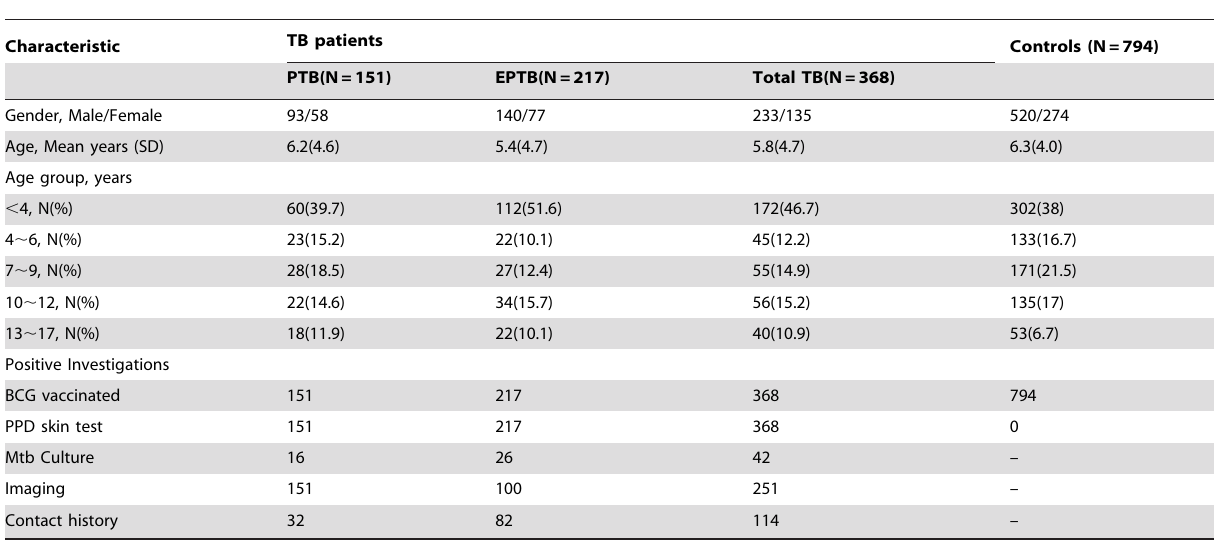
Table 1. Characteristics of study